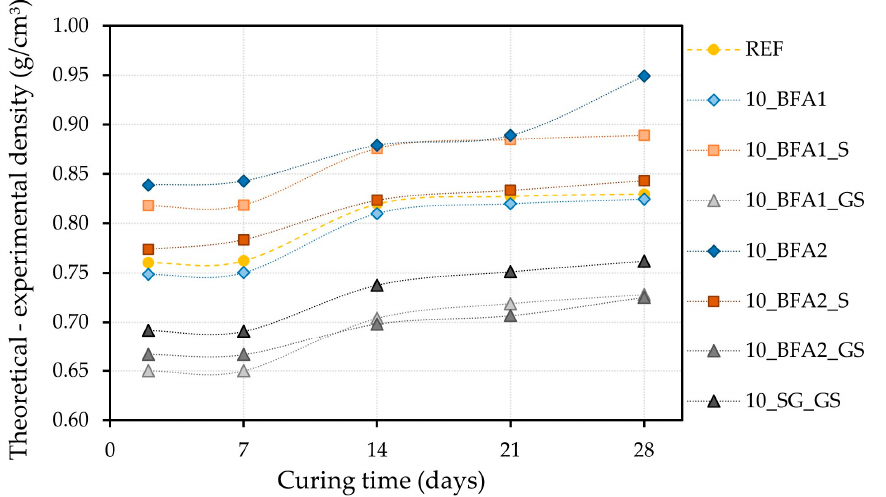
Figure 5. Differences between the theoretical and the determined experimental density for the 10.0 wt.% waste-containing mortars during the 28 days of curing. 10.0 wt.% waste-containing mortars during the 28 days of